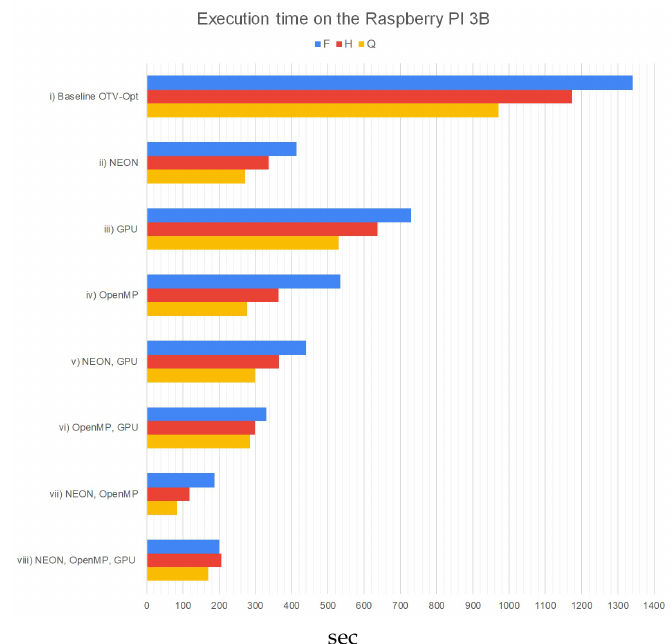
Figure 10. Execution time in seconds of the OTV-Opt algorithm on the Raspberry PI 3B at the three resolutions F, H and Q with different optimization strategies: (i) the vanilla baseline OTV-Opt with a single core without further optimizations, (ii) single core with NEON instructions, (iii) single core with the integrated GPU, (iv) using all the four cores with OpenMP, (v) single core with the integrated GPU exploiting NEON instructions, (vi) four cores and the GPU, (vii) using all the four cores with OpenMP exploiting NEON instructions, and finally (viii) combining all optimizations (GPU, NEON and